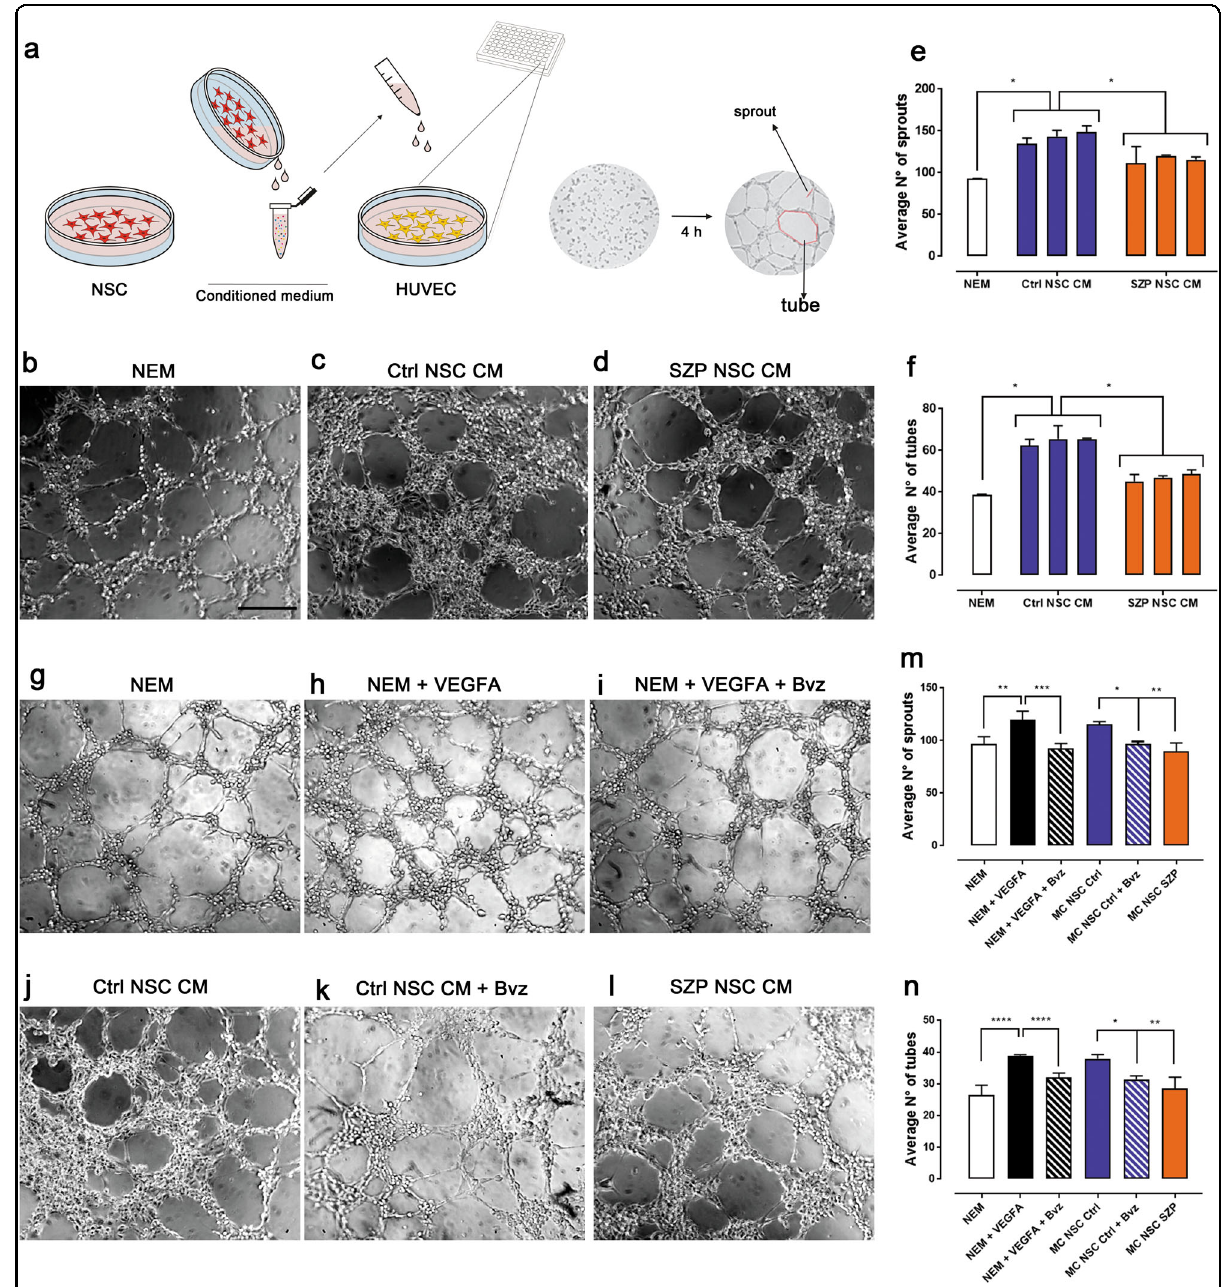
Fig. 3 SZP NSC CM induce less angiogenesis and migration in vitro than Ctrl NSC CM. a Cartoon representing the experimental design of the tube formation assay. After 48 h, CM was collected from NSC cultures and applied on HUVEC seeded on matrigel coated wells. After 4 h, tubes (closed polygons) and sprouts were counted. b – d Representative images of tube formation assay when incubating HUVEC on Neural Expansion Media (NEM, used as negative control ( b ), Ctrl NSC CM ( c ) or SZP NSC CM ( d ); Scale bar = 30 µm. e – f Quanti fi cation of average number of sprouts ( e ) or tubes ( f ) formed in each condition. Data for each cell line (Ctrl #1,#2, #3 and SZP #1, #2, #3) is shown in a correlative order control and graphed as mean ± SD with * p < 0.05 according to Kruskal-Wallis test. g – n Ctrl NSC CM was incubated with 100 µg/ml of bevacizumab (Bvz) to inhibit VEGFA signaling. g – l Representative images of tube formation assay when incubating HUVEC on NEM ( g ), NEM plus 50 ng/ml VEGFA ( h ), NEM plus 50 ng/ml VEGFA with 100 µg/ml of bevacizumab (Bvz) inhibitor ( i ), Ctrl NSC CM ( j ), Ctrl NSC CM with 100 µg/ml Bvz ( k ) or SZP NSC CM ( l ). m – n Quanti fi cation of average number of sprouts ( m ) or tubes ( n ) formed in each condition. Data is shown as mean ± SD with * p < 0.05, ** p ≤ 0.01 and *** p ≤ 0.001 according to Kruskal – Wallis